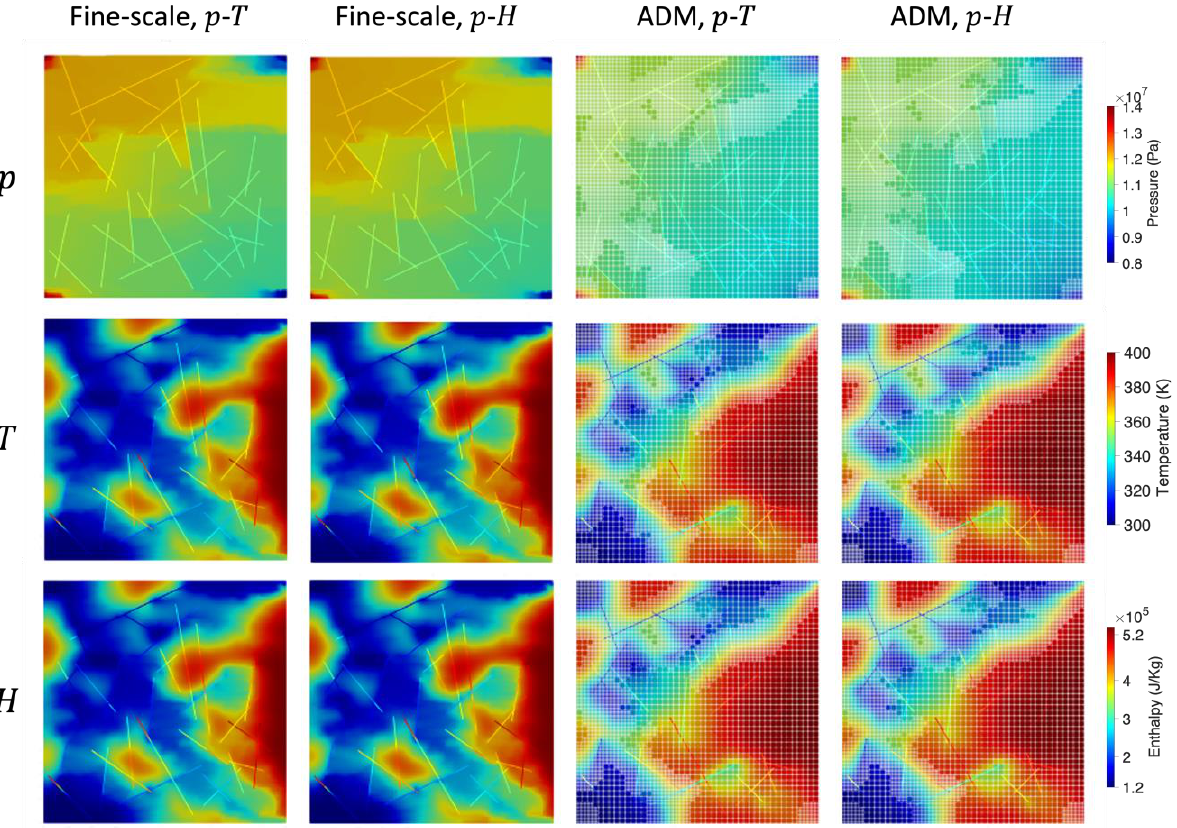
Figure 5. The pressure ( top row ), temperature ( middle row ), and the total enthalpy ( bottom row ) of the fine-scale and ADM simulations, both for the natural and the molar formulation.